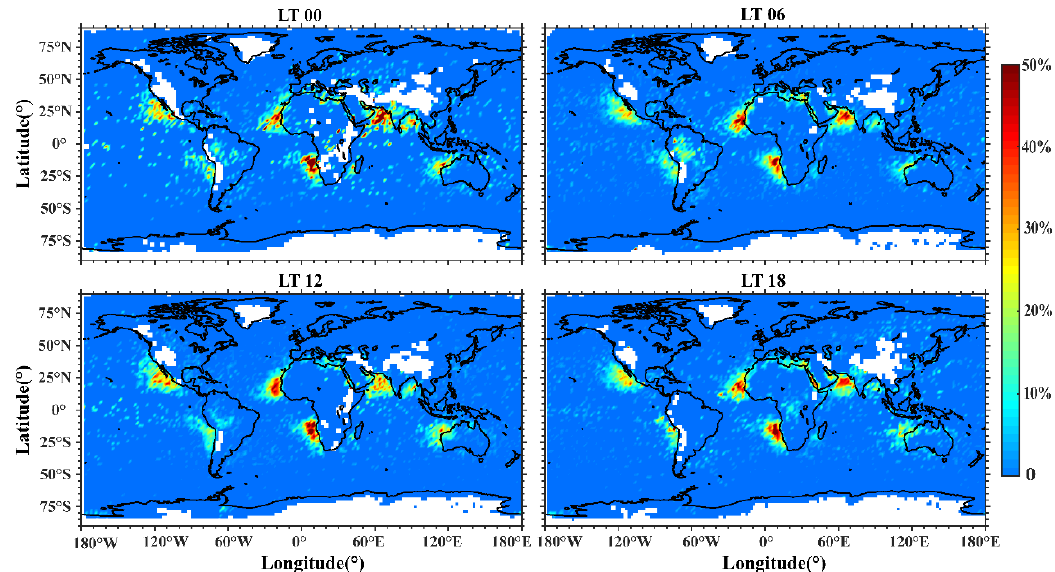
Figure 6. Distribution of the trapping layer occurrence rate with local time variations. The blank grids represent that there is no radio occultation event.